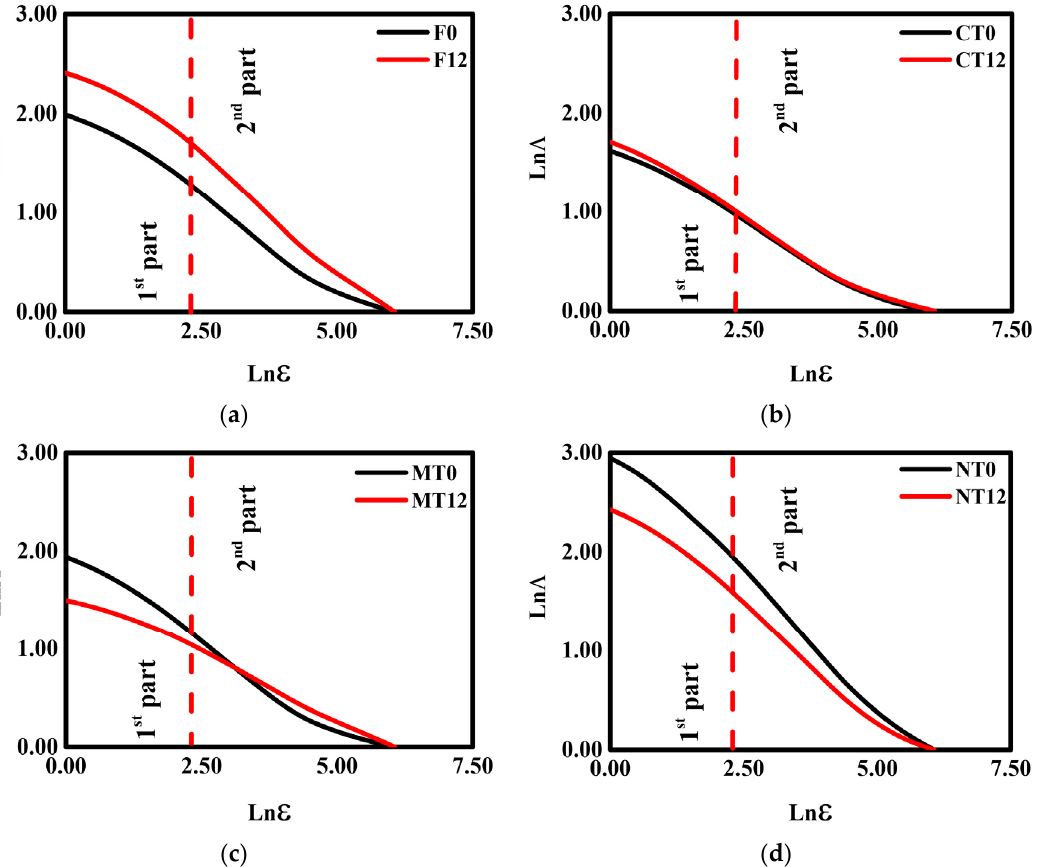
Figure 1. 3D lacunarities ( Λ ) of the samples submitted to 0 and 12 wetting and drying (W-D) cycles. ( a ) Secondary forest—F; ( b ) conventional tillage—CT; ( c ) minimum tillage—MT; ( d ) no tillage—NT. The divisions into two parts (first and second) were made based on the regions where the best linear adjustments occurred in the curves. ε is the box size.